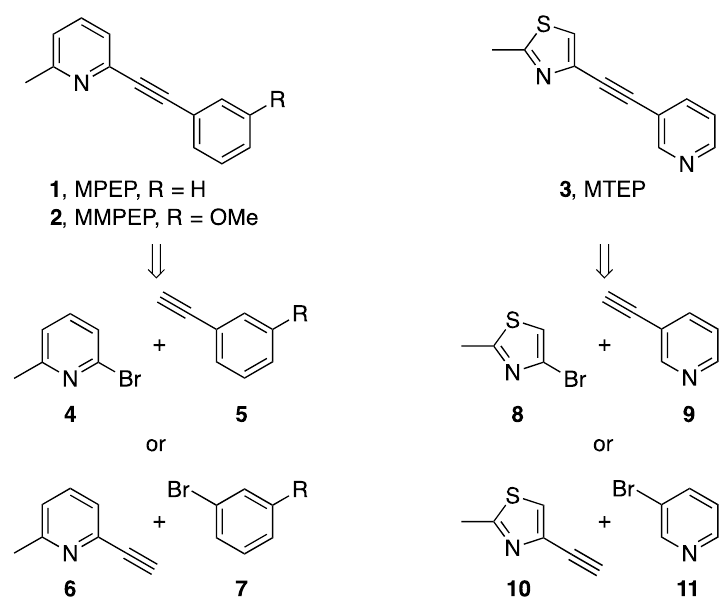
Figure 1. Structures of MPEP ( 1 ), MMPEP ( 2 ) and MTEP ( 3 ) and their assembly via the Sonogashira cross-coupling.